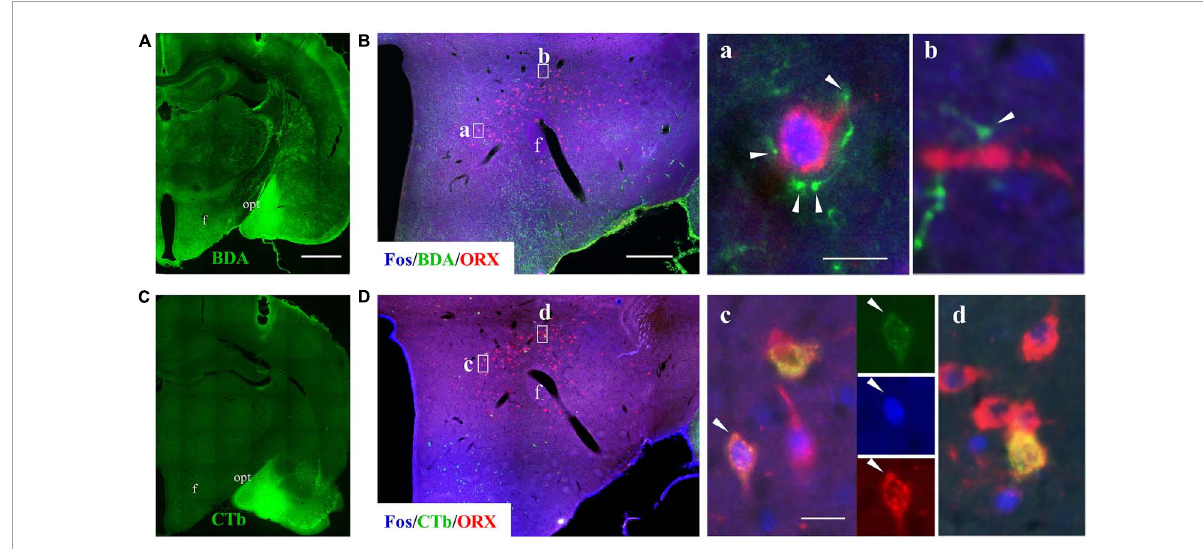
FIGURE7 Pilocarpine-induced SE caused activation of reciprocal connections between medial amygdala and ORX neurons. Panels (A,C) show staining for BDA and CTb (which was co-injected into medial amygdala) in two serial coronal sections from a seizure rat. (B) A representative image of triple immunofluorescent staining for Fos (blue), BDA (green), and ORX (red) in the hypothalamus of a rat subjected to pilocarpine-induced SE, with squared areas (a,b) enlarged in the right panels. Note that BDA-labeled fibers and terminal boutons encircle a Fos + /ORX + soma (a) or in close contact with ORX + axon (b). (D) A representative image of triple immunostaining for Fos (blue), CTb (green), and ORX (red) in the hypothalamus of the same rat, with squared areas enlarged in the right panels. Note that some seizure-activated (Fos + ) ORX neurons were labeled with CTb. Bar: 1,000 µ m in (A,C) , 400 µ m in (B,D) , and 20 µ m in a–d. f, fornix; opt, optic